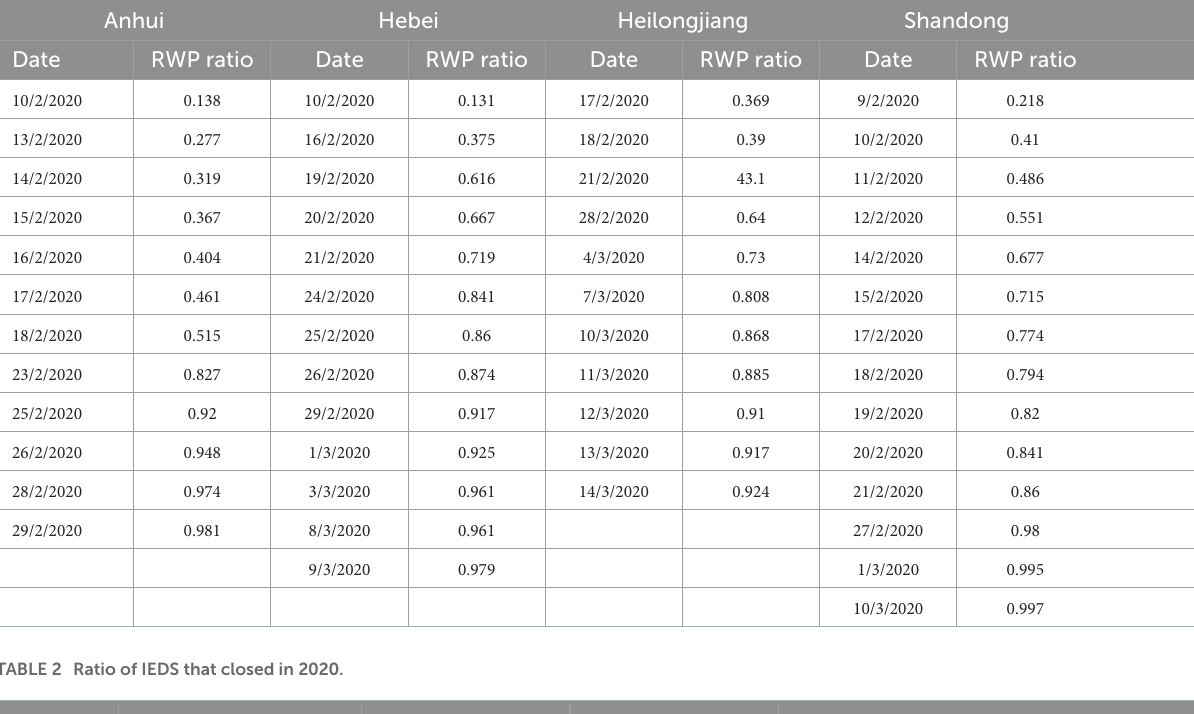
TABLE 1 Data on resumption of work and production (RWP) of IEDS. Anhui